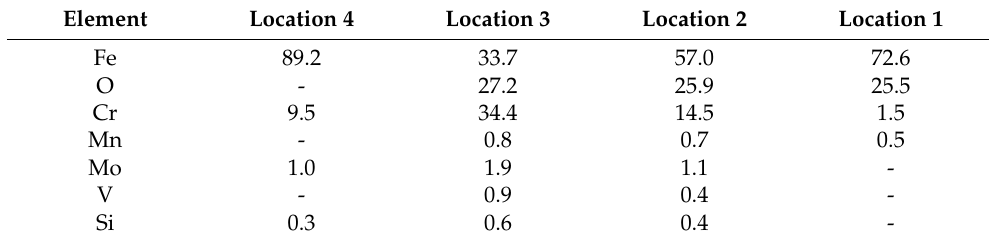
Table 3. Quantitative EDX analysis, sample P91 oxidized at 600 ◦ C for 2000 h (in wt.%).